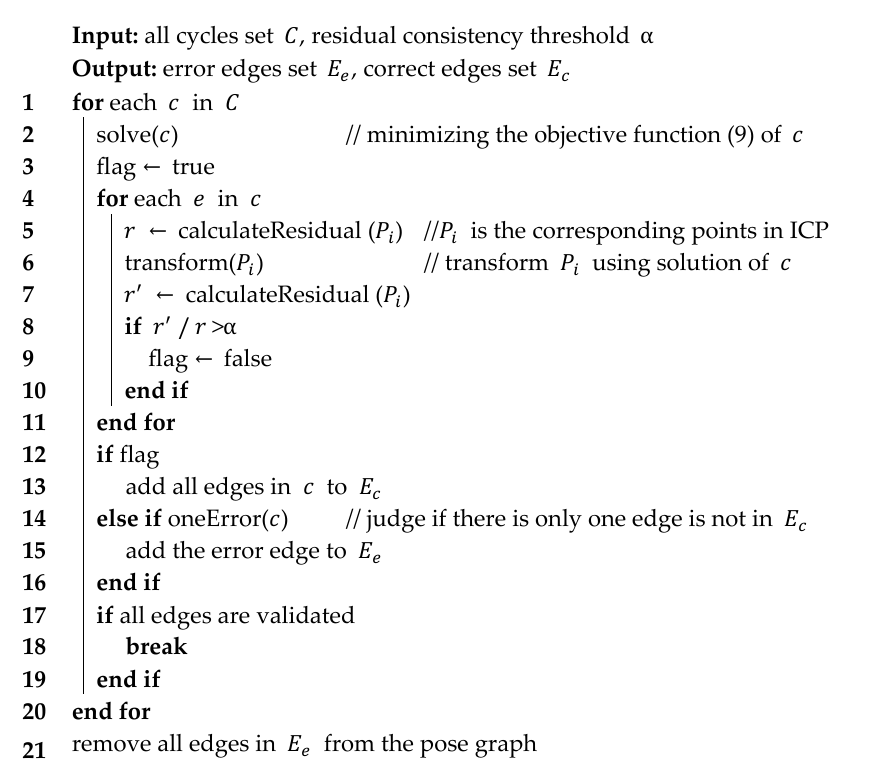
Figure 5. The illustration of operator 𝑋𝑜𝑟 . The blue dotted lines denote the edges which are present in both inputs that are removed first, and then the remaining edges and nodes are merged into one.